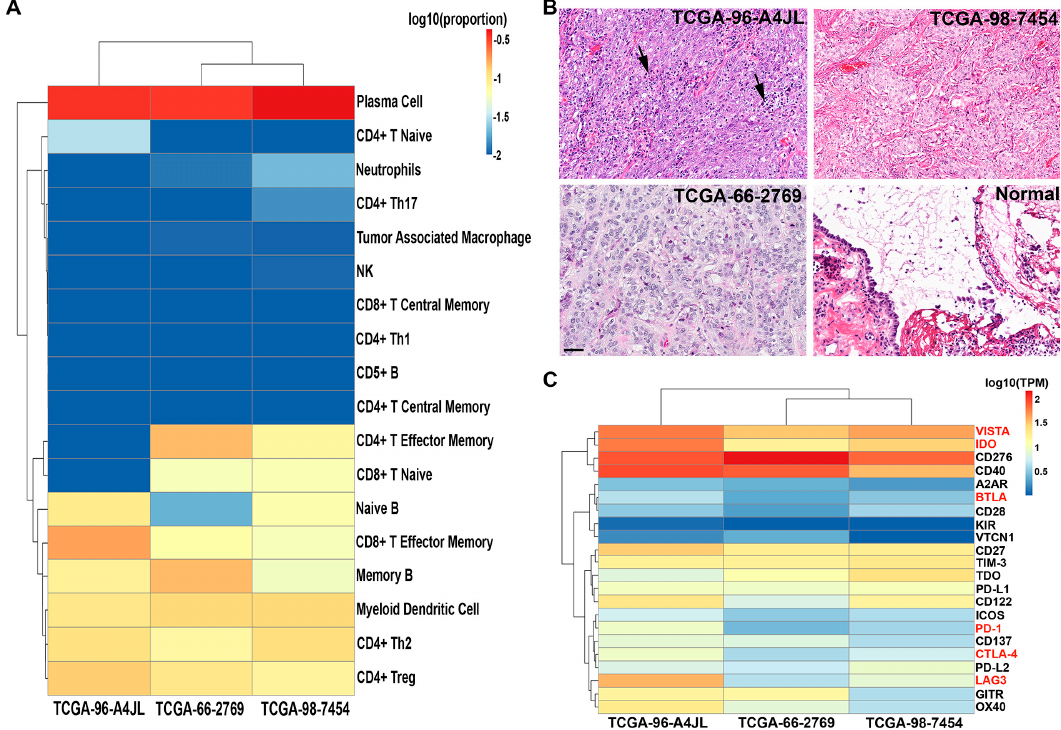
Figure 8. Immune infiltration status of EBV( + ) NSCLCs. ( A ) Fractions of immune cell subsets in EBV( + ) NSCLC samples inferred from gene-expression data using CIBERSORT. CIBERSORT empirical p value, p < 0.001. ( B ) Representative images of hematoxylin and eosin staining of EBV( + ) NSCLC and adjacent normal lung samples. Arrowheads point to the infiltrating immune cells. Scale bar: 50 µ m. ( C ) A high EBV level is associated with enhanced expression of immune checkpoint molecules in EBV( + ) NSCLC samples. Heatmap shows transcripts levels of known cellular checkpoint molecules in EBV( + ) NSCLC samples. Checkpoint molecules that were significantly up-regulated in the EBV-high sample are highlighted in red. Unsupervised hierarchical cluster analysis shows the separation of EBV-low and EBV-high